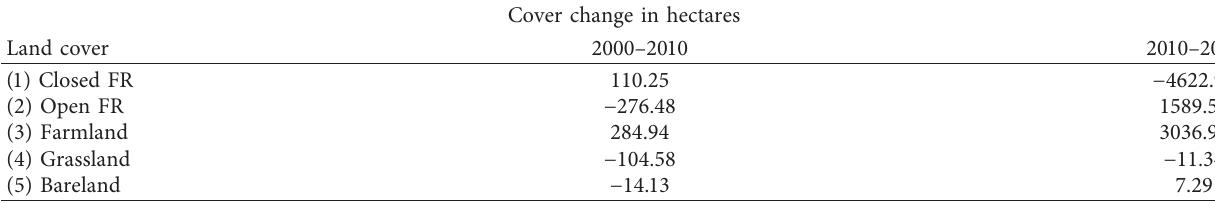
Table 10: Forest land cover areas in hectares (ha) lost and gained.